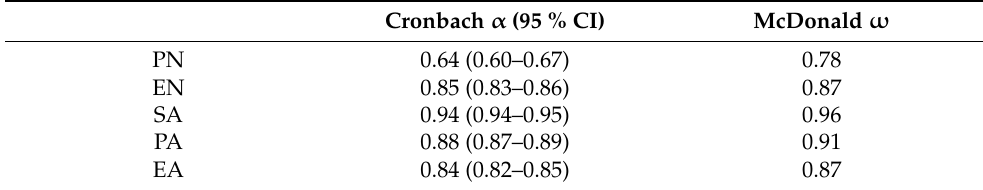
Table 3. Internal consistency of the individual subscales of the CTQ.